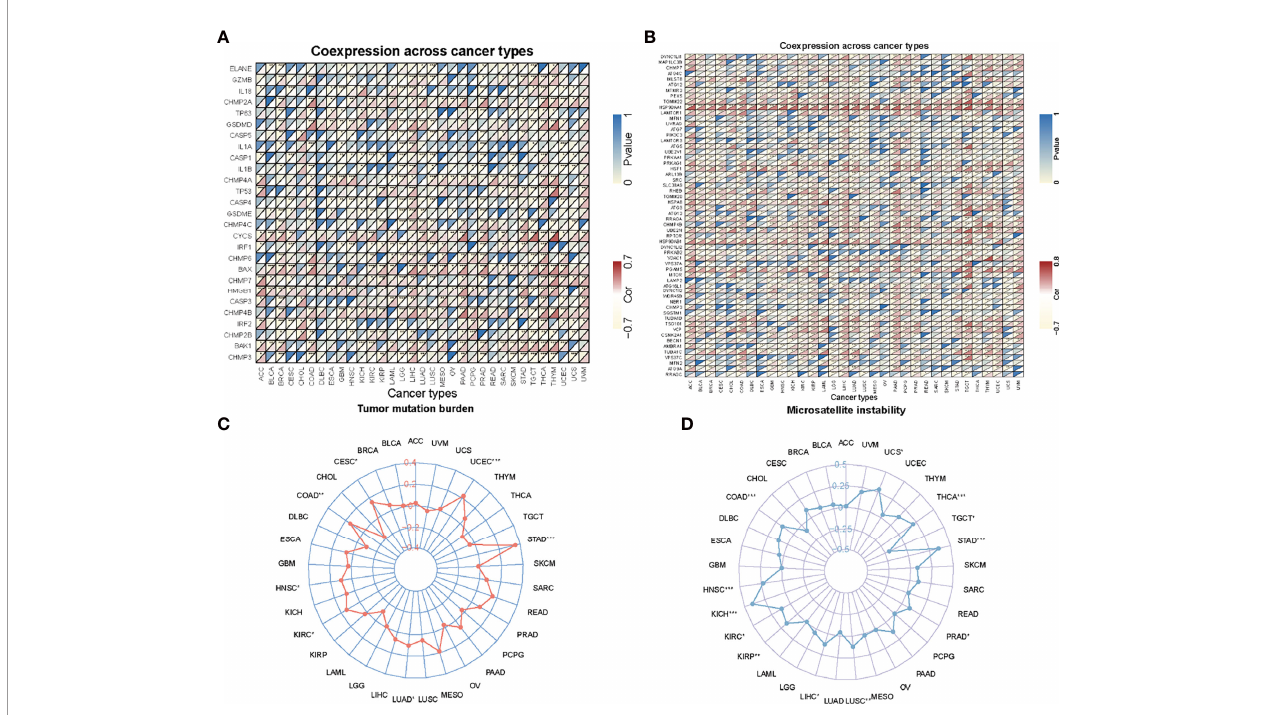
FIGURE 4 | Correlation analysis. (A) Correlation analysis of AHSA1 expression and pyroptosis-related molecules. (B) Correlation analysis of AHSA1 expression and autophagy-related molecules. (C) Correlation between AHSA1 expression and Tumor mutation burden. (D) Correlation analysis of AHSA1 expression and Microsatellite instability. *p<0.05, **p<0.01,